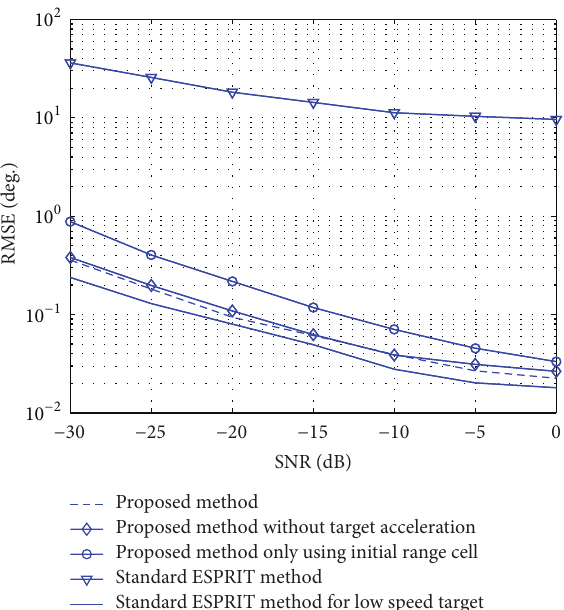
Figure 5: RMSEs of DOD and DOA estimation versus SNR for target